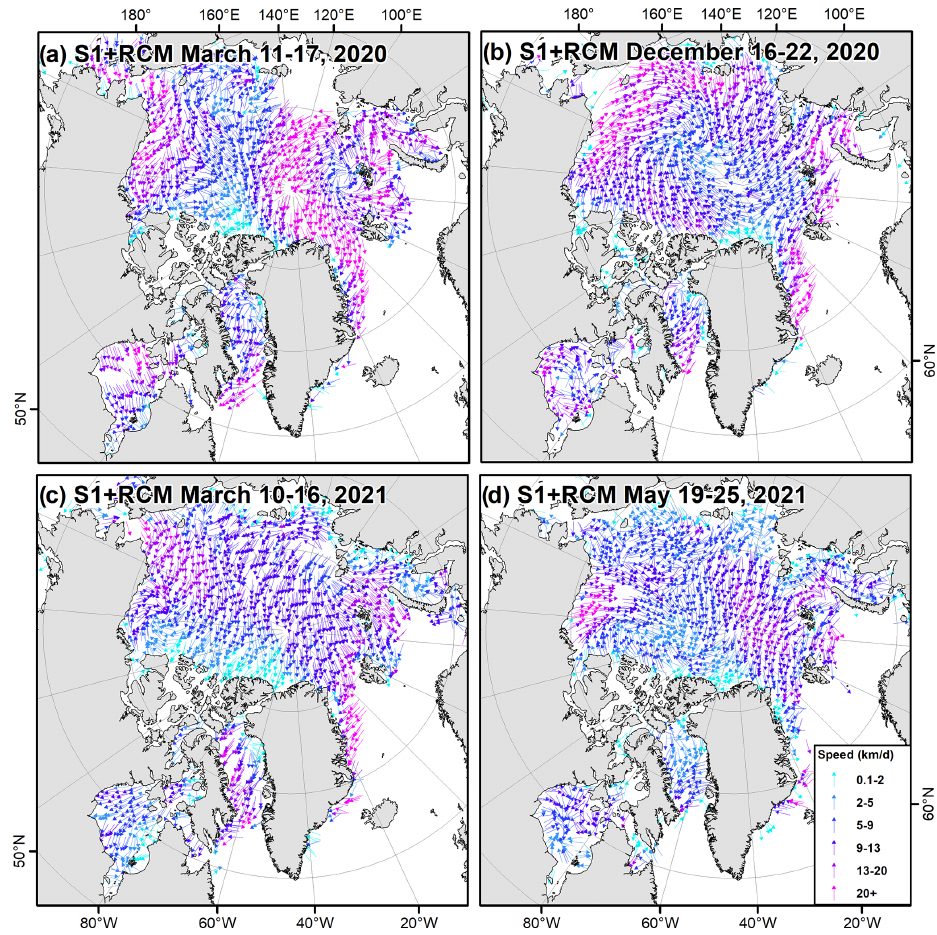
Figure 8. The spatial distribution of 25km 7d S1 + RCM sea ice motion on (a) 11–17 March 2020, (b) 16–22 December 2020, (c) 10– 16 March 2021, and (d) 19–25 May 2021. Note that the white areas in the figure indicate either zero ice motion for the landfast ice or no ice motion information extracted (because of no SAR data, no ice, or no stable ice